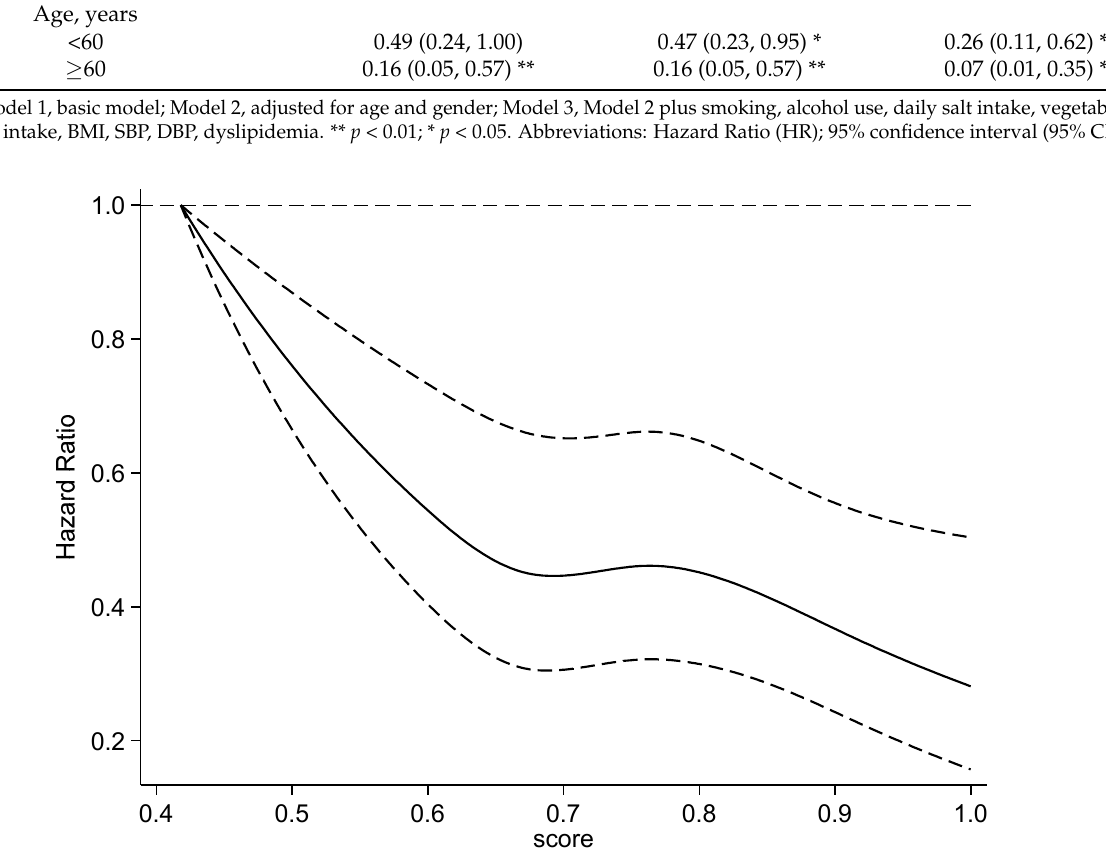
Table 2. Association between the efficiency score and risk of incident hypertension.